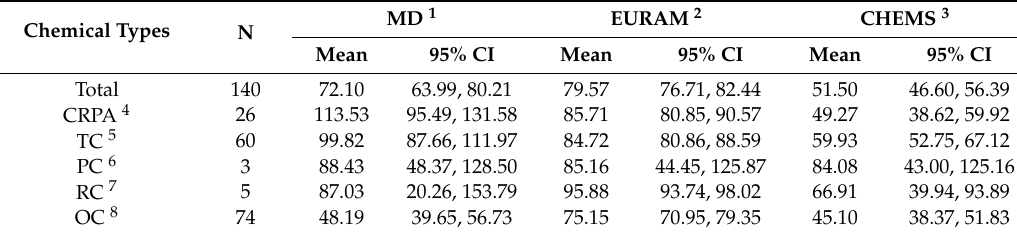
Table 7. Arithmetic mean and 95% confidence interval (CI) of hazard scores by types of chemicals classified according to the Korea Chemicals Control Act.